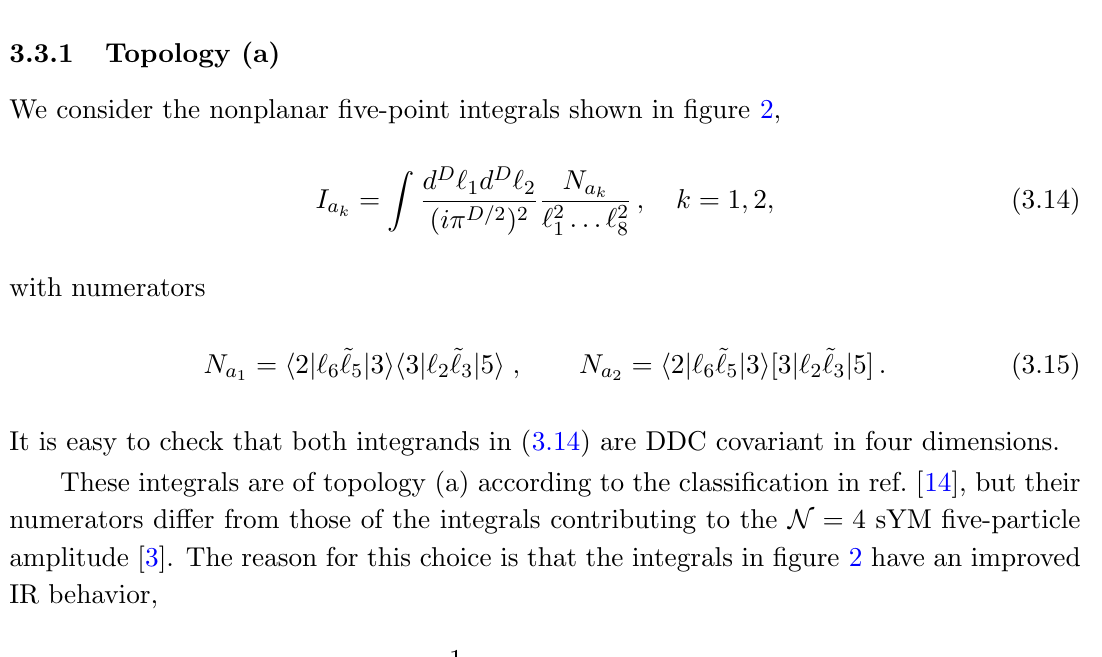
Figure 2 . Integrals of topology ( a ) with numerators N a the fermion propagators and fermion external states that form the